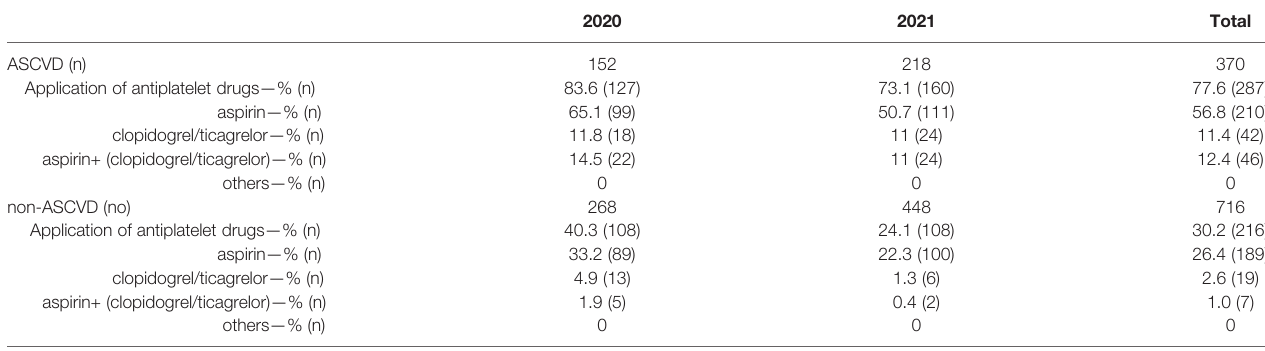
TABLE 7 | Application of antiplatelet drugs of type 2 diabetic inpatients with or without